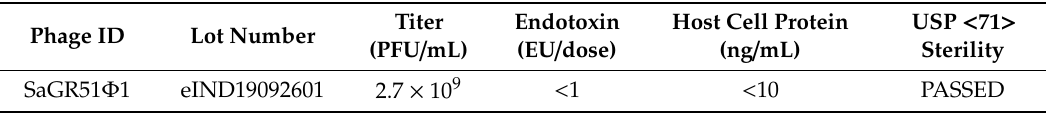
Table 1. Final therapeutic preparation details provided to this patient for the treatment of S. aureus prosthetic joint infections (PJI)